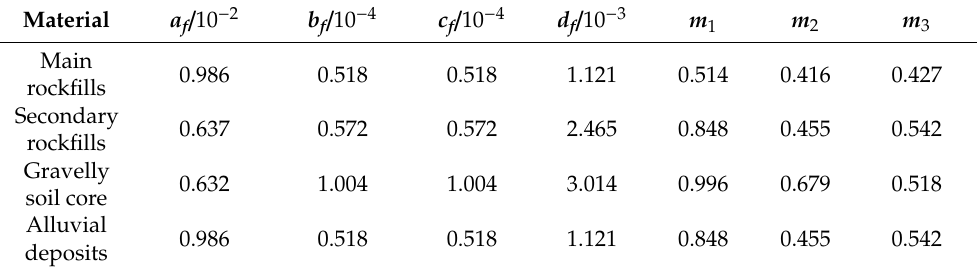
Table 4. Calibrated parameters of the wetting deformation model for the upstream rockfills.